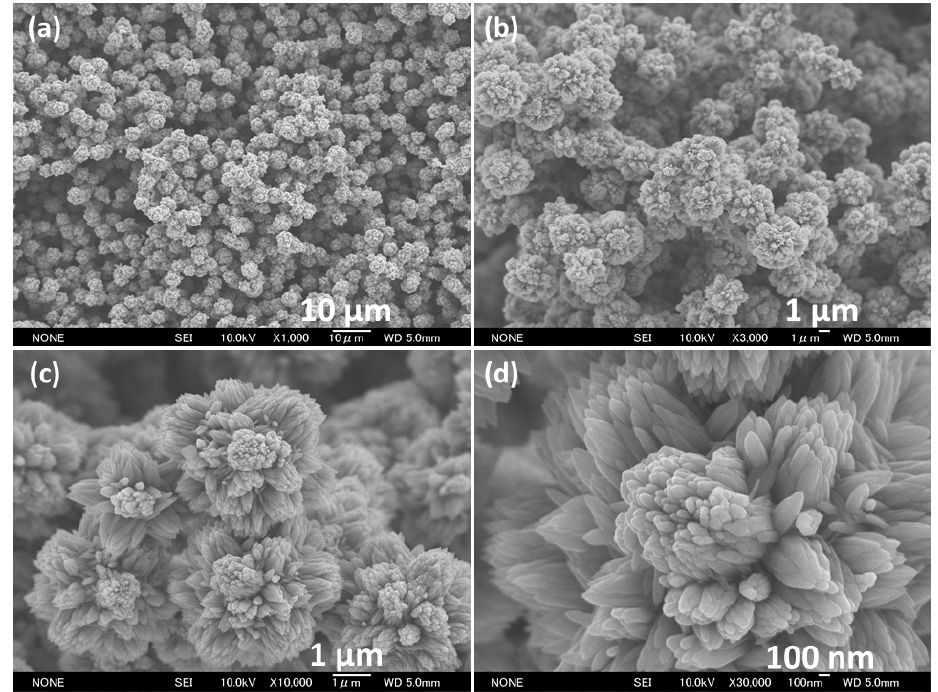
Figure 2. Typical field-emission scanning electron microscopy (FESEM) images ( a–d ) of flower-shaped ZnO nanostructures directly grown on FTO